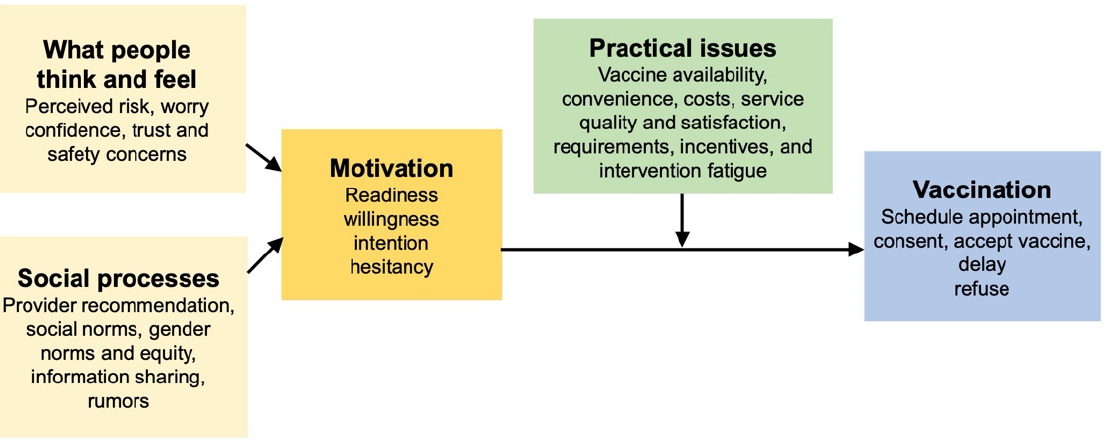
Figure 1. The Increasing Vaccination Model (2017) [13].